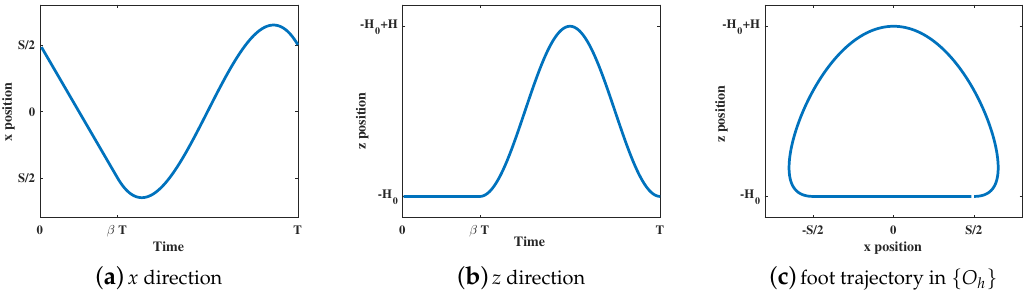
Figure 8. The foot trajectory